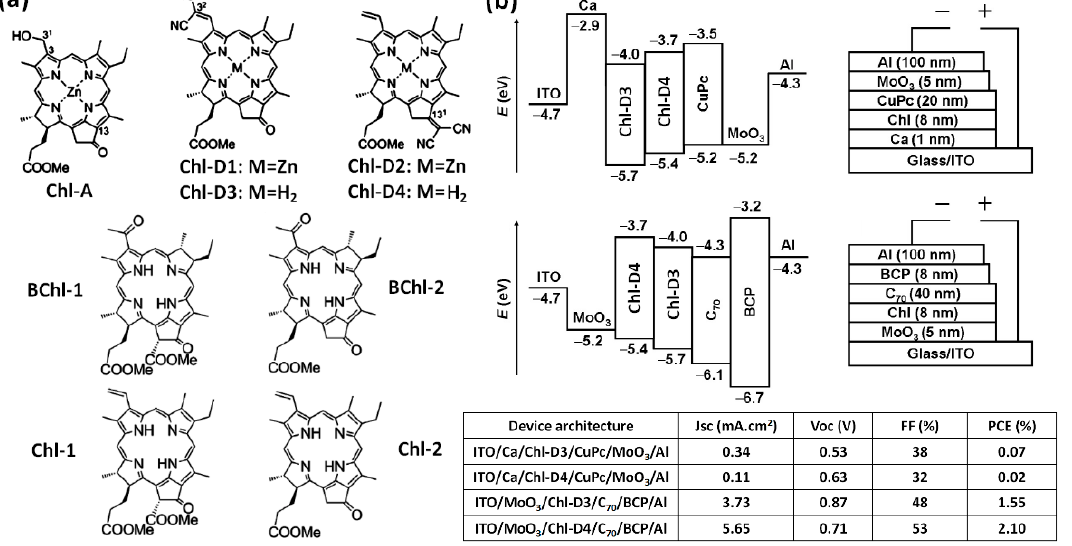
Figure 6. ( a ) Molecular structures of chlorophyll-derivatives; ( b ) device architecture and